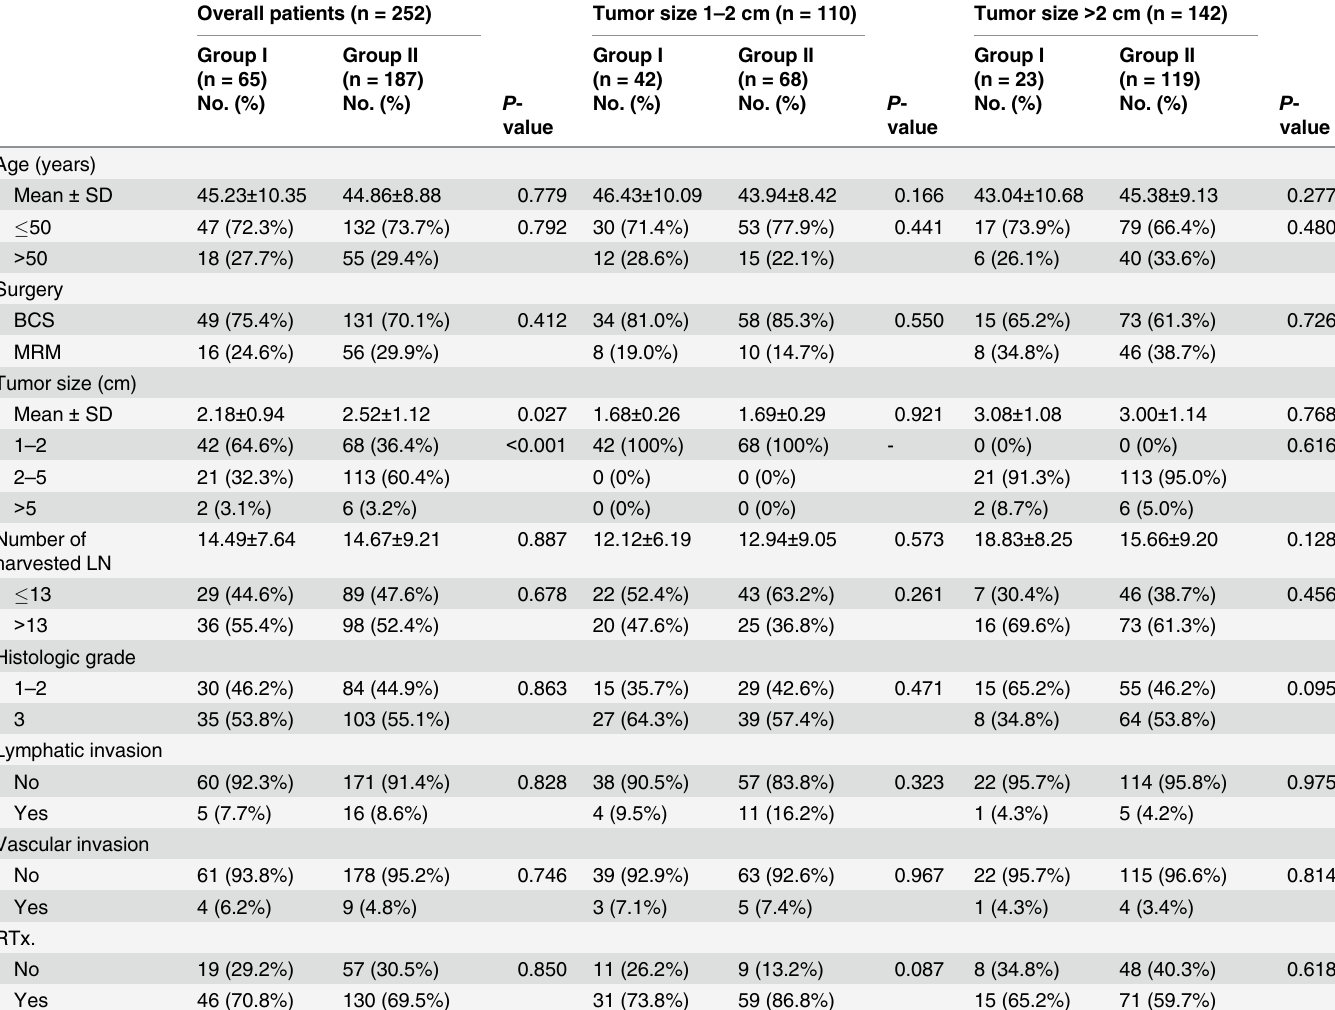
Table 1. Baseline patient characteristics.